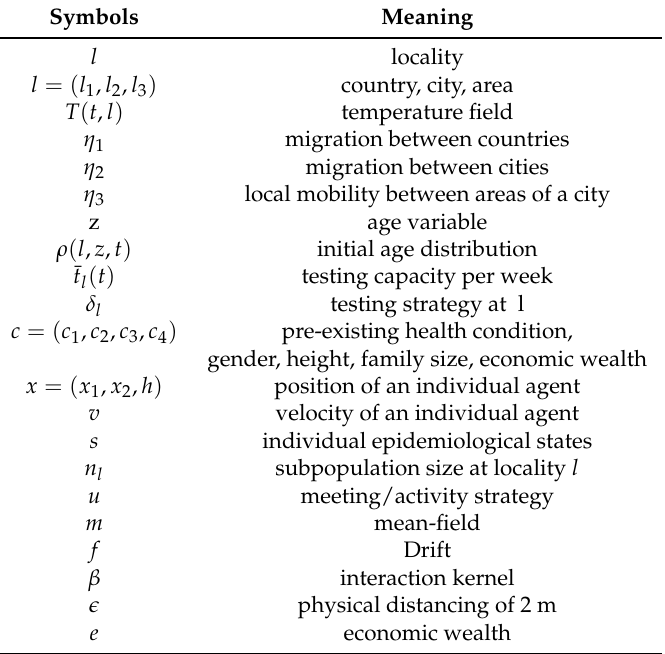
Table 3. Some notations used the proposed